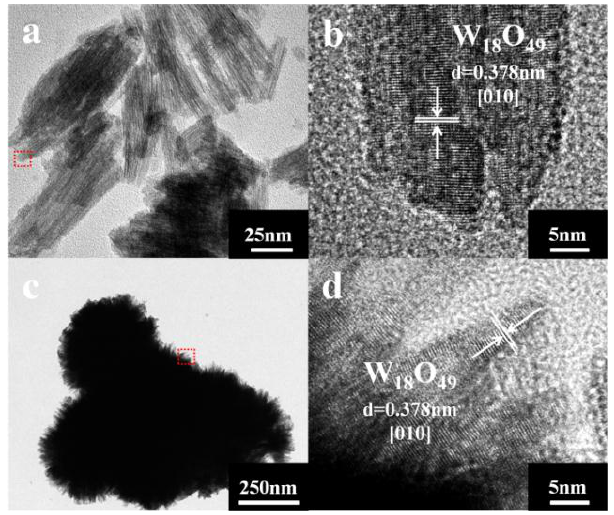
Figure 3. Transmission electron microscope (TEM) images of the products prepared with different reaction times: ( a ) 3 h; ( c ) 6 h. Corresponding selected area electron diffraction (SAED) patterns were obtained at the center of the red rectangles in the TEM images: ( b ) 3 h; ( d ) 6 h.